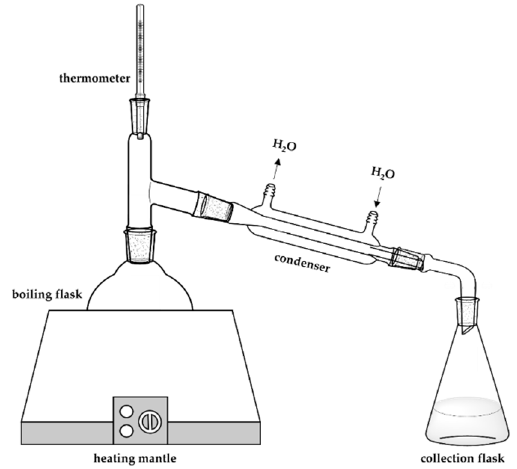
Figure 4. Experimental setup used in steam distillation.